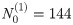
Biofilm growth simulation for bi-bacterial biofilm with independence or competition model.Mean of 100 simulations in blue line with green star for the hours of experimental measurements, dotted lines for curves of minimum and maximum values, red diamonds for experimental data, initial proportion corresponding to the initialization of the mono-bacterial biofilms (36% for P. gingivalis: N0(1)=144, N0(2)=261): (a) P. gingivalis and S. gordonii independent, (b) P. gingivalis and S. gordonii in competition for nutrient.